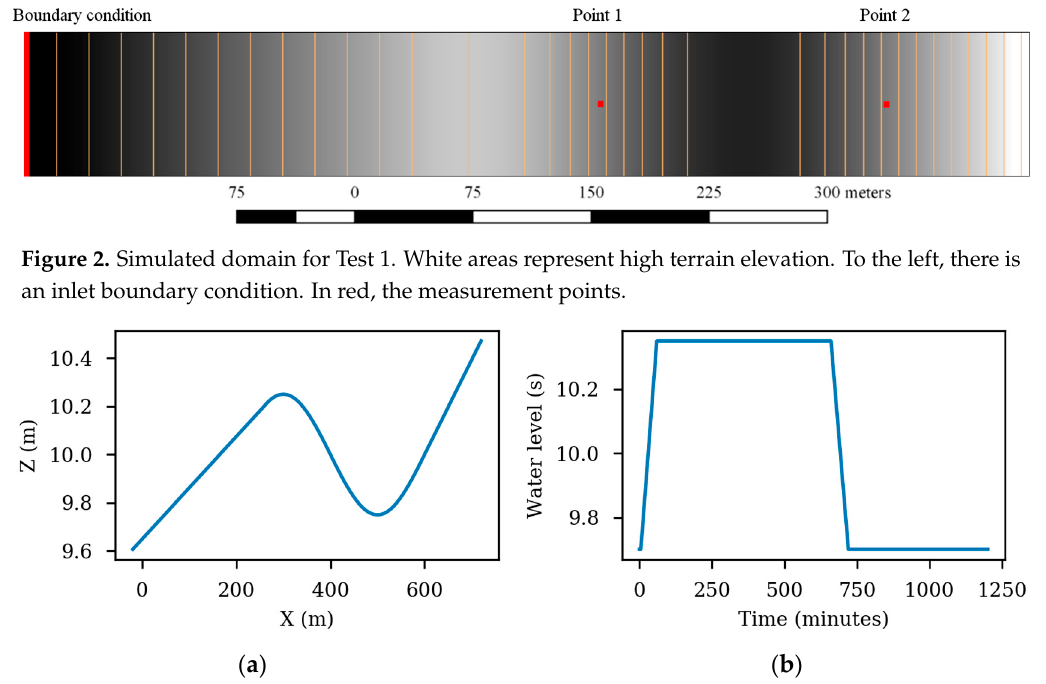
Figure 3. Elevations along the domain. Z stands for elevation in meters and X for horizontal distance from the origin of the channel ( a ). Hydrograph defined for the inlet boundary condition ( b ).